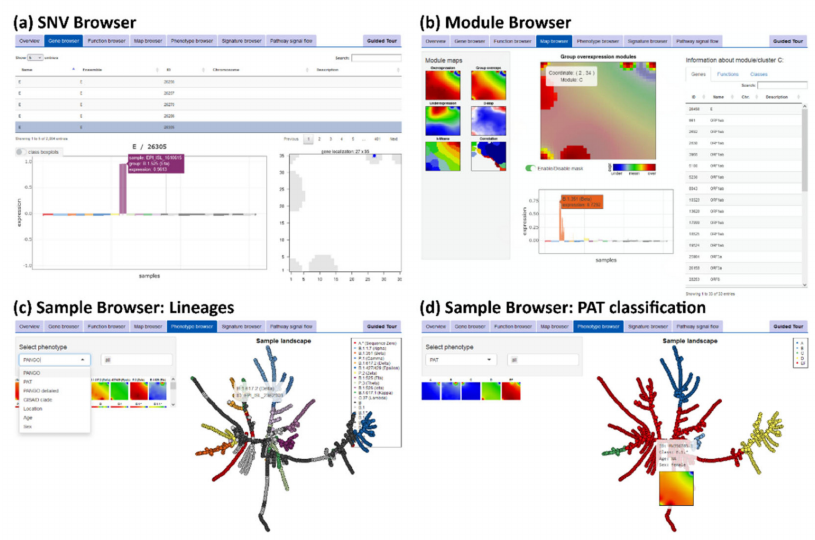
Figure A11. Screenshots of the different oposSOM browser functionalities to explore the SARS- CoV-2 variants data. ( a ) The gene browser shows the SNV profiles and mapping into the SOM grid (localization) of selected sequence positions. ( b ) The module browser provides access to the different SOM segmentation methods and shows spot-cluster SNV profiles and associated SNV for the interactively selected spot. ( c) The sample landscape shown in the phenotype browser can be grouped according to a selection of different phenotypes. Here the PANGOLIN classification is shown. Hovering the nodes of the landscape provides the variant ID and the corresponding class. ( d ) The sample landscape grouped according to our PAT classification. Clicking any node in the graph (i.e., a particular variant sample) reveals further information and the respective meta-SNV portrait. See also Figure A12.